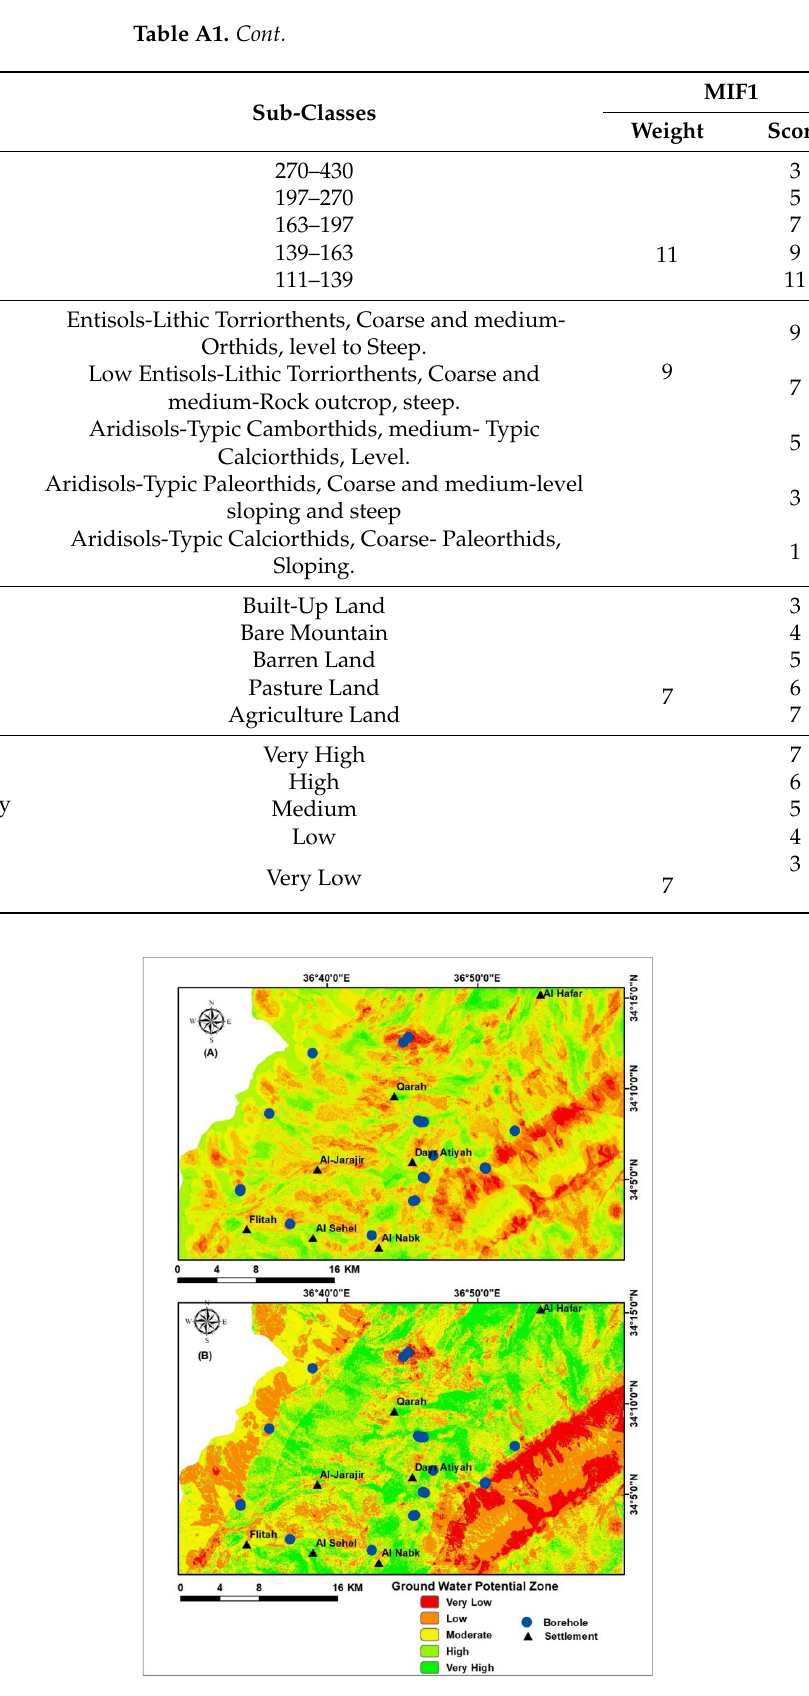
Figure A1. Groundwater Potential Zone of the ( A ) AHP1 and ( B ) MIF1 maps.